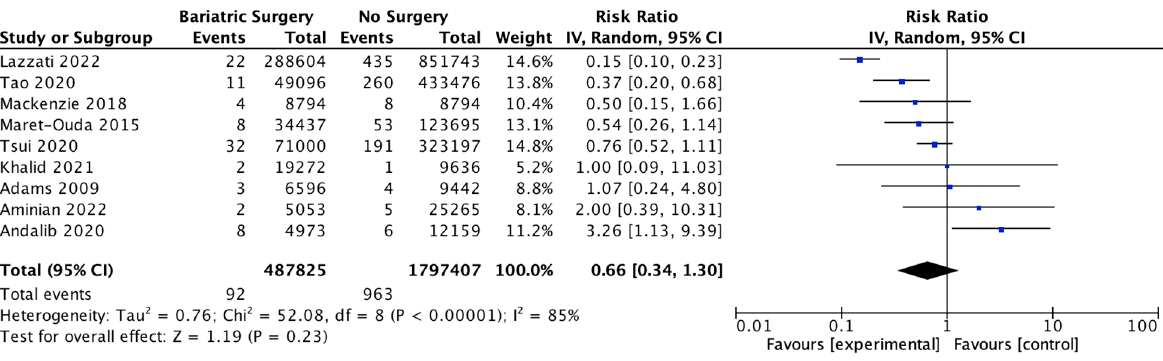
Figure 10. Oesophageal adenocarcinoma incidence [38–40,42,43,45,49,64,65].